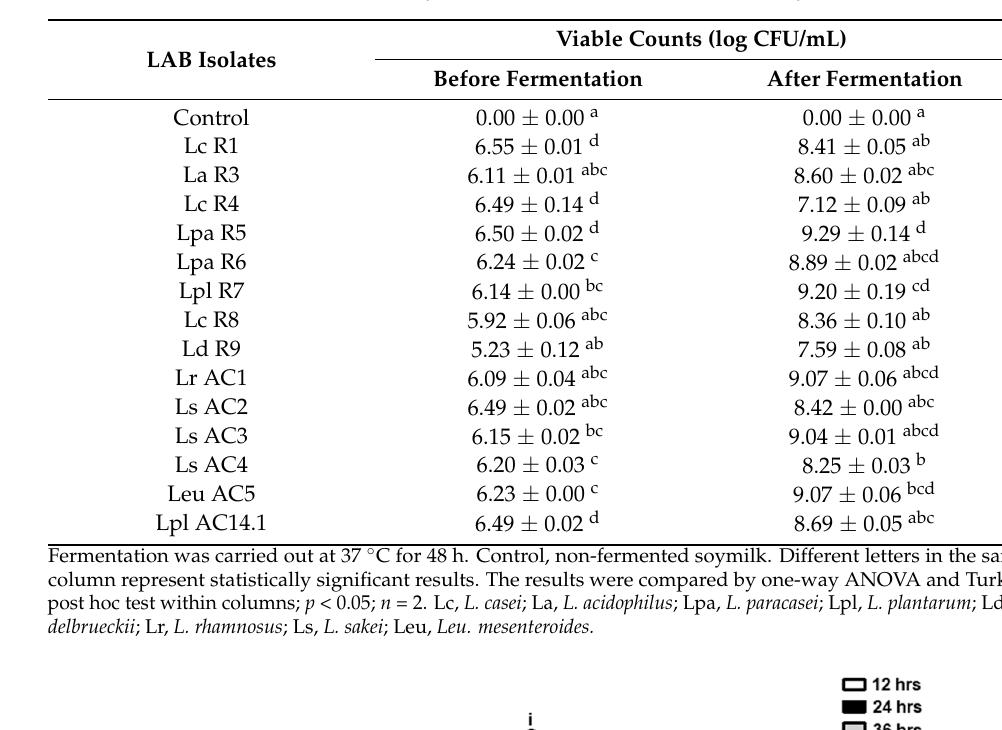
Table 2. Viable counts of fermented soymilk before and after fermentation by selected LAB isolates.